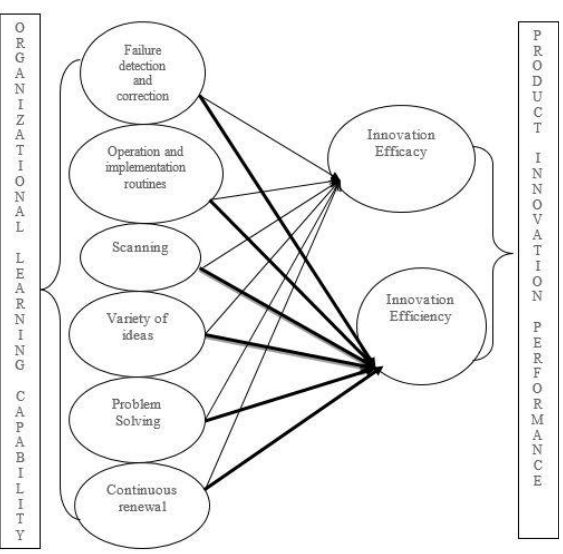
Figure 1. Conceptual Model of the Research Source: Figure complied by authors